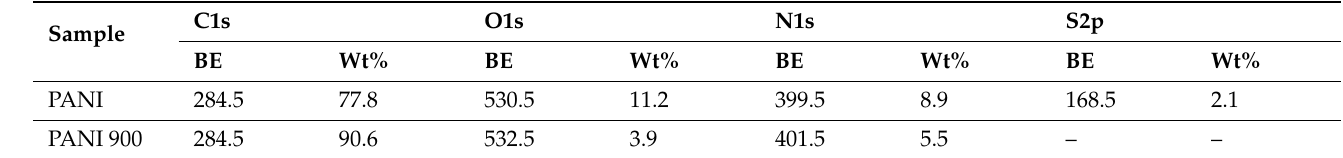
Table 1. The detected elements and the relative atomic concentrations of PANI and PANI 900.